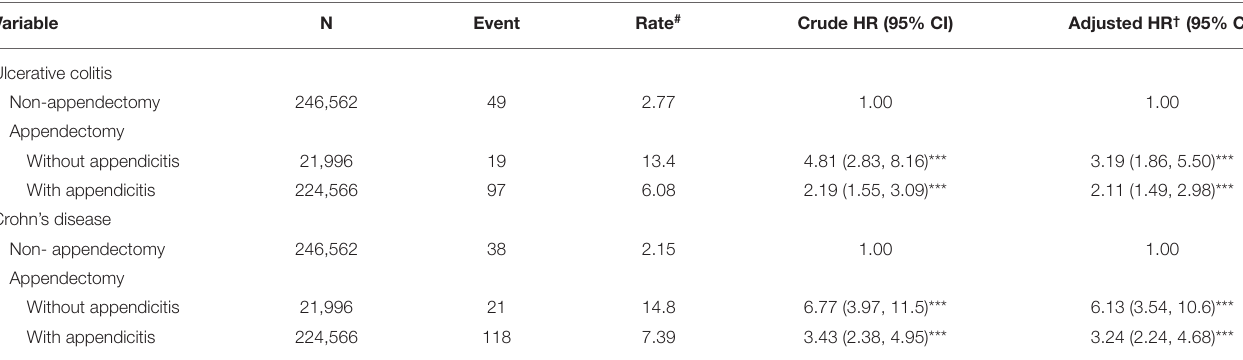
TABLE 4 | Comparison of the HRs of ulcerative colitis and Crohn’s disease among patients who underwent appendectomy with and without appendicitis and controls.